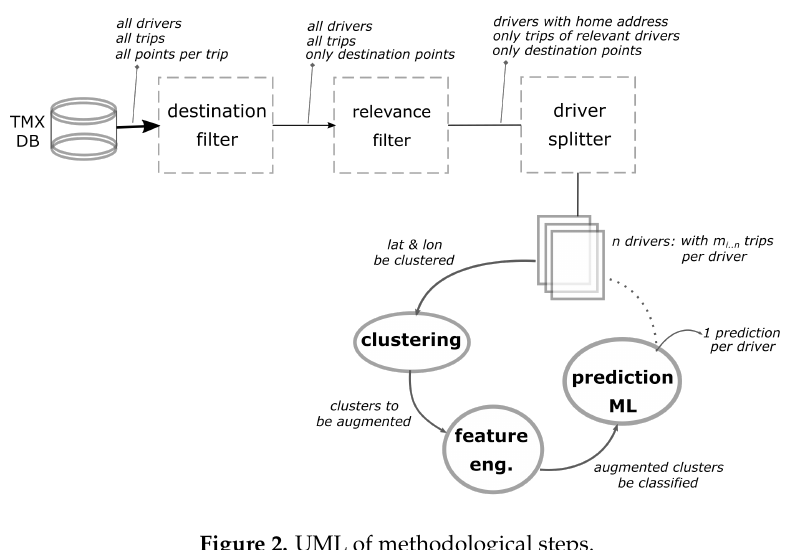
Figure 2. UML of methodological